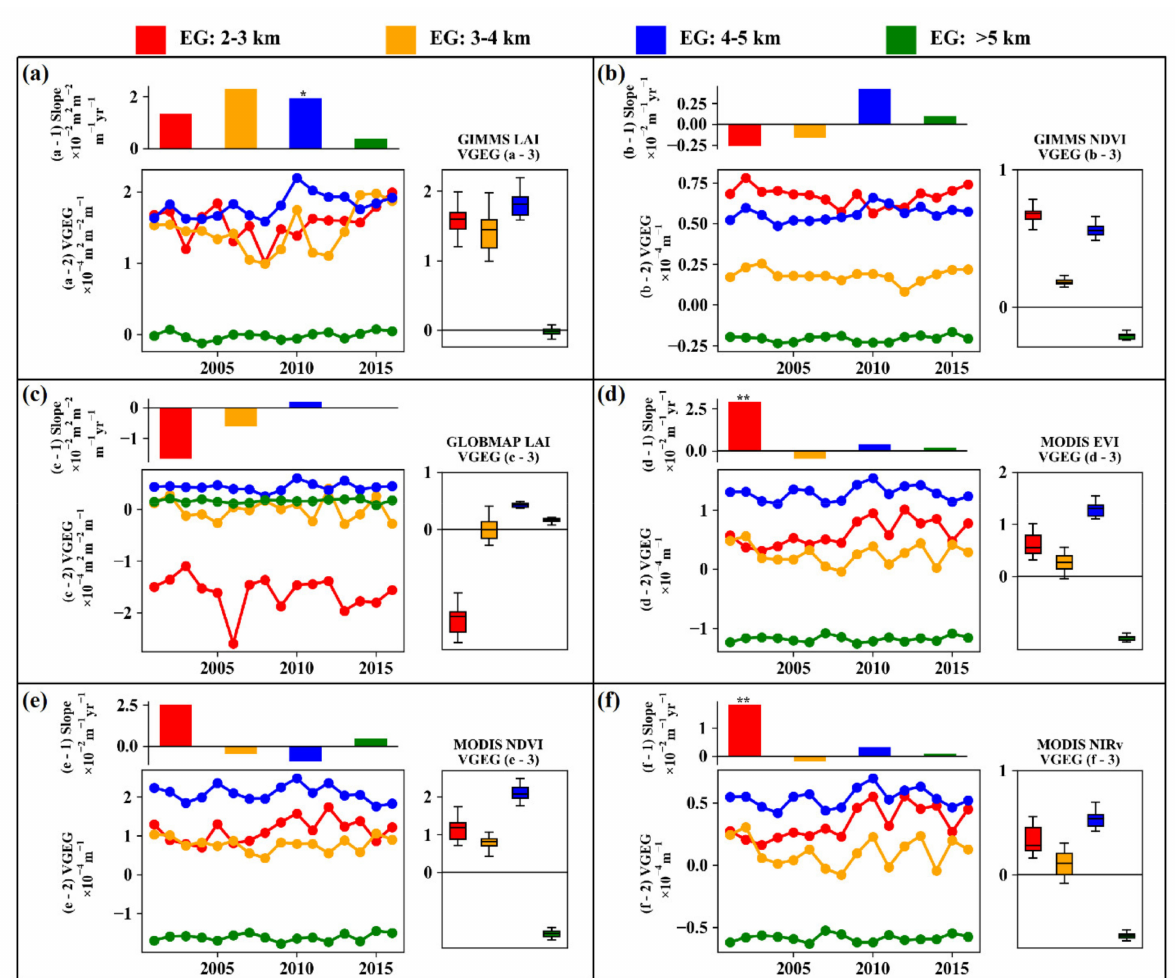
Figure 9. Trend of VGEGs in different elevations from 2001 to 2016 (( a ): Global Inventory Modeling and Mapping Studies leaf area index (GIMMS LAI); ( b ): GIMMS Normalized Difference Vegetation Index (NDVI); ( c ): Global Mapping (GLOBMAP) LAI; ( d ): Moderate Resolution Imaging Spectroradiometer Enhanced VI (MODIS EVI); ( e ): MODIS NDVI; ( f ): MODIS near-infrared reflectance of vegetation (NIRv)). Take ( a ) as an example (the same meaning of panels b – f ). a-1 is the slope of VGEG. a-2 is the mean annual VGEG value represented by circles of various colors at different elevations from 2001 to 2016. a-3 denotes the statistical values of VGEG, which share the same unit with a-2. The asterisks indicate that the slope is statistically significant (*: p < 0.05; **: p <